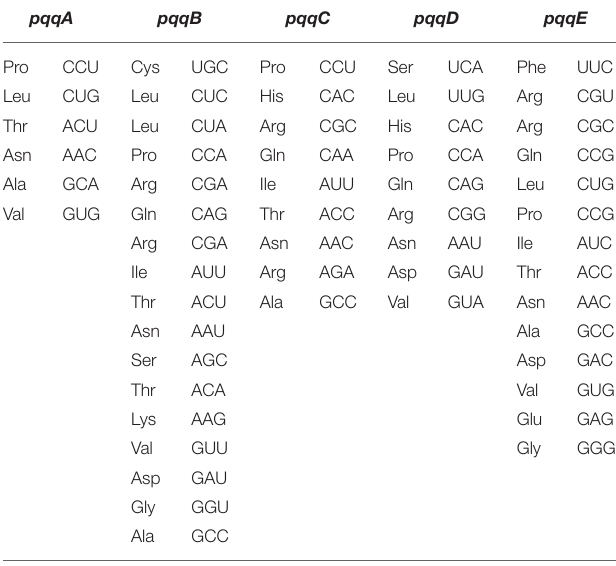
TABLE 4 | Optimal codons in the pqqA – pqqE genes in different organisms based on their RSCU values.